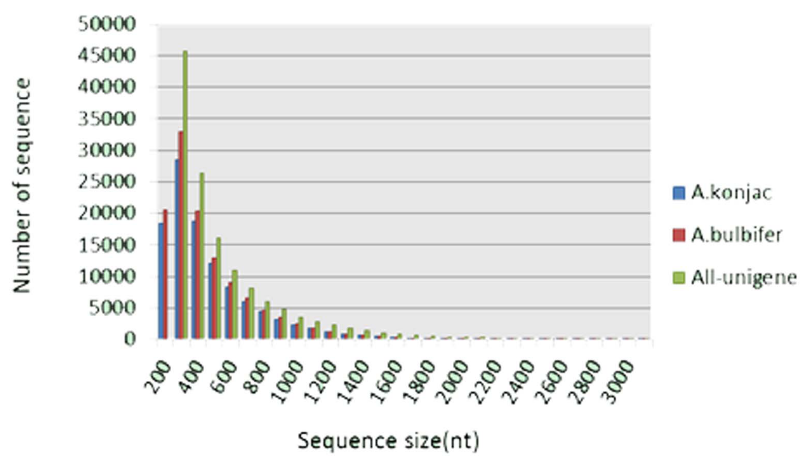
Figure 1. Statistics of unigene assembly qualities. All sizes of the Unigenes were calculated.